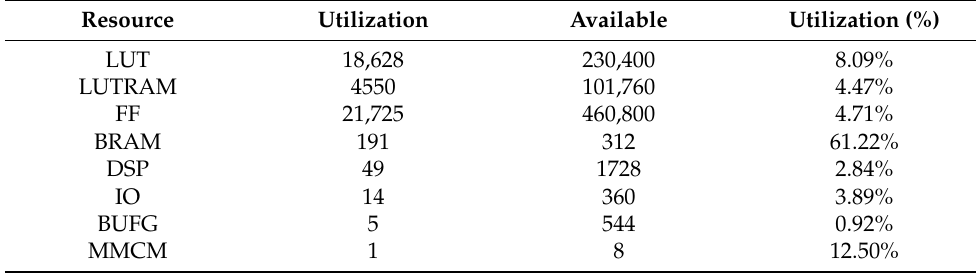
Table 2. FPGA resources